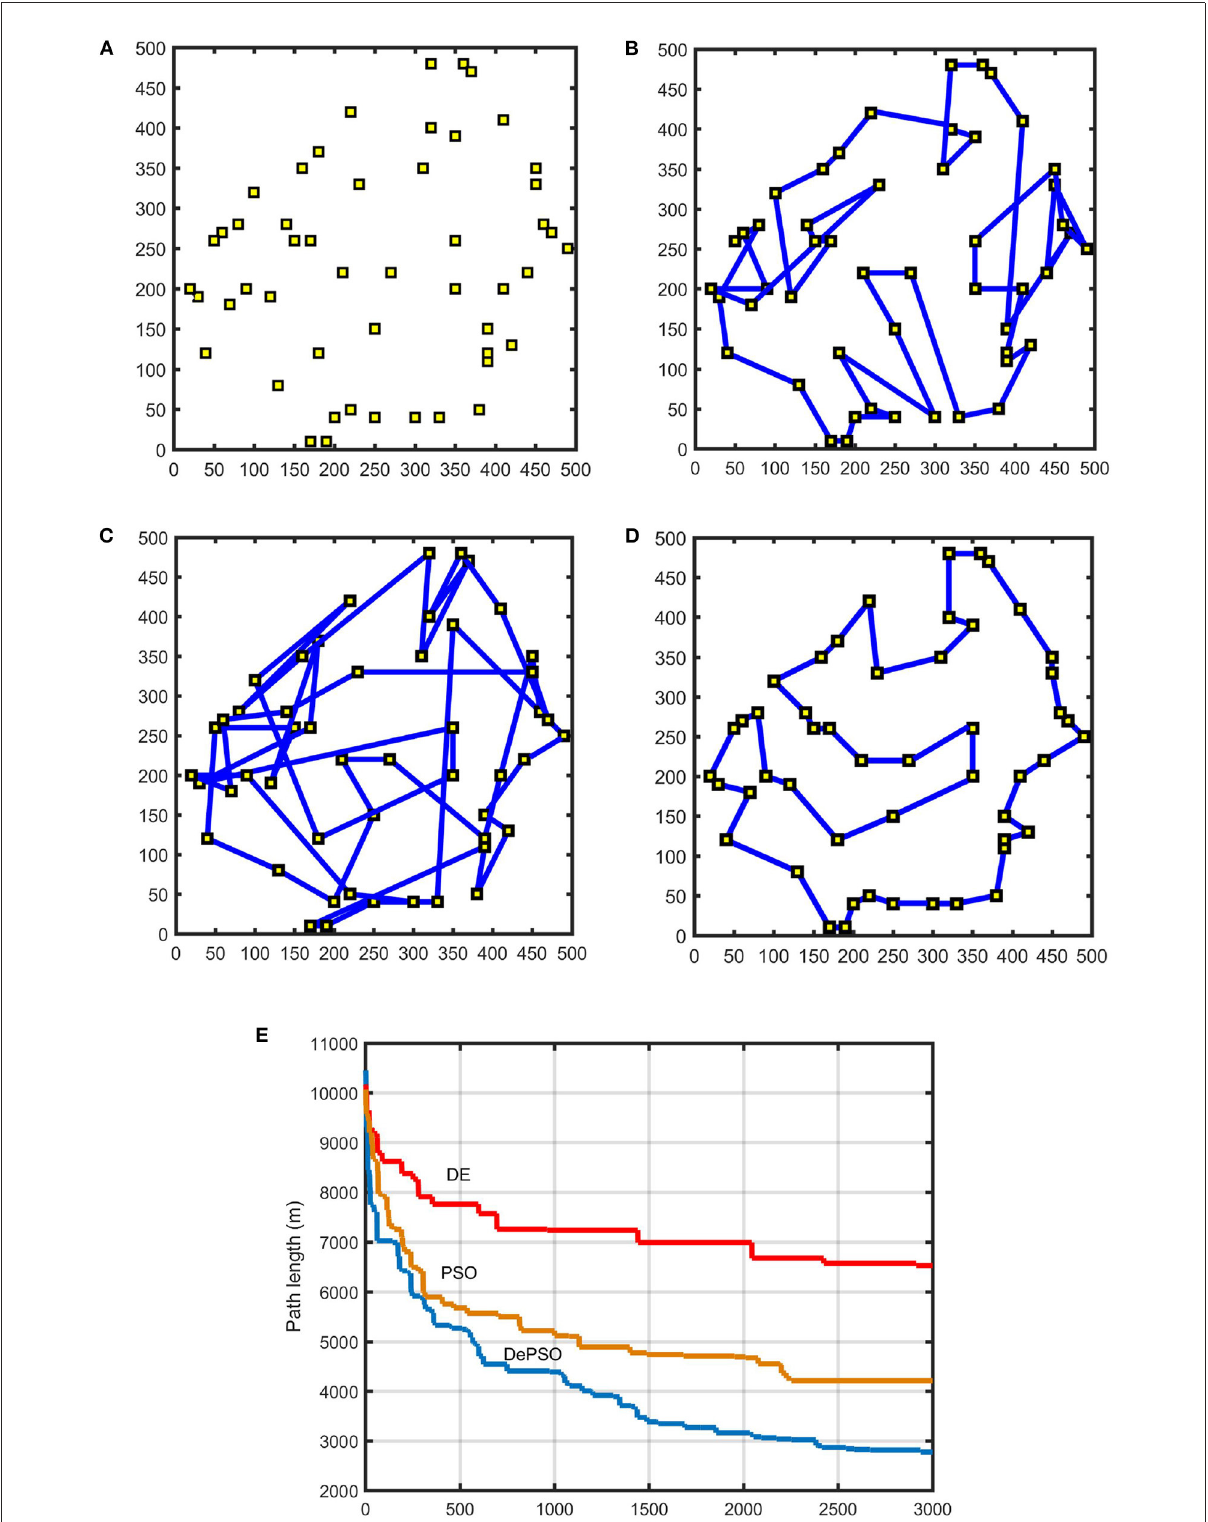
FIGURE8 Path planning results for 50 sampling points: (A) Distribution of 50 sampling points. (B) Path planning result with conventional PSO. (C) Path planning result with conventional DE. (D) Path planning result with DePSO. (E) Path length iterative process